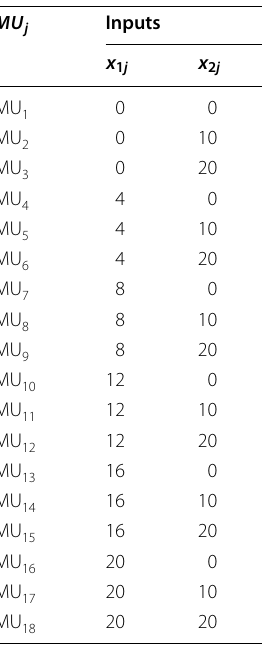
Table 7 BCC-efficiency of DMUs